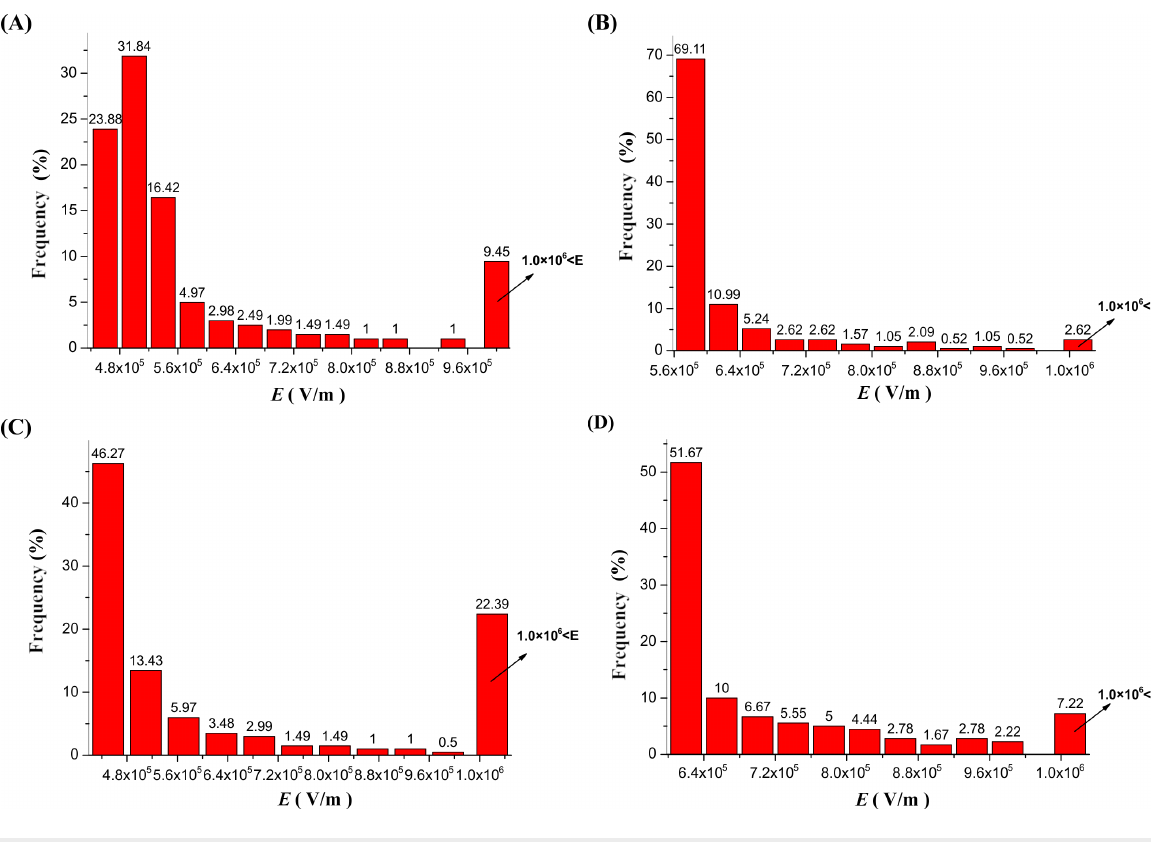
Figure 10: Distribution of the electric field along the radial axis (0–20 mm). A, B, C and D correspond to the MBE, MFSE, OSFSE and SSFSE device.